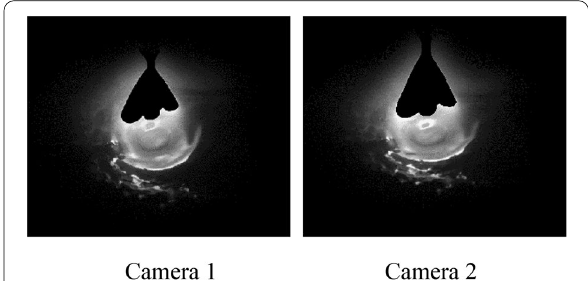
Figure 7 SURF feature points of the welding pool image under the arc (240 A, 33 V, 0.6